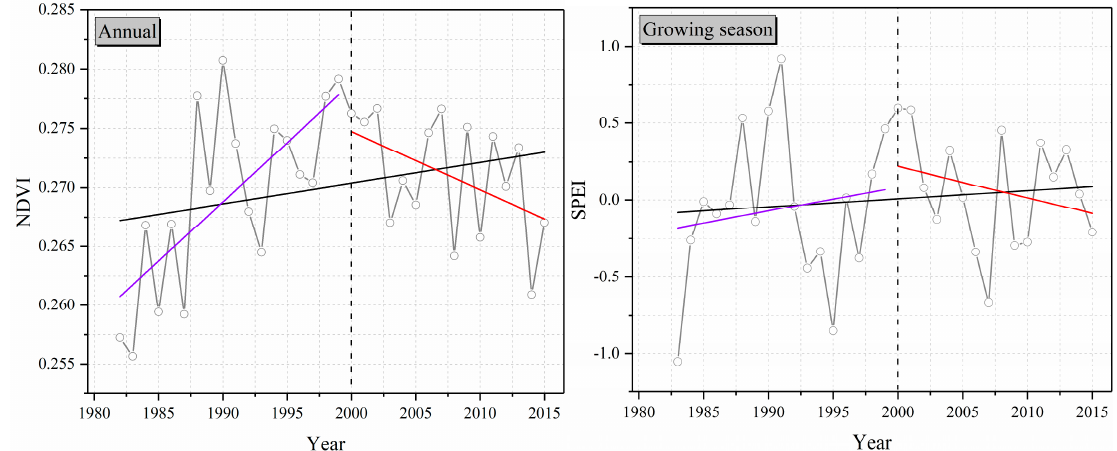
Figure 5. Changes of the annual ( left ) and growing season ( right ) SPEI.